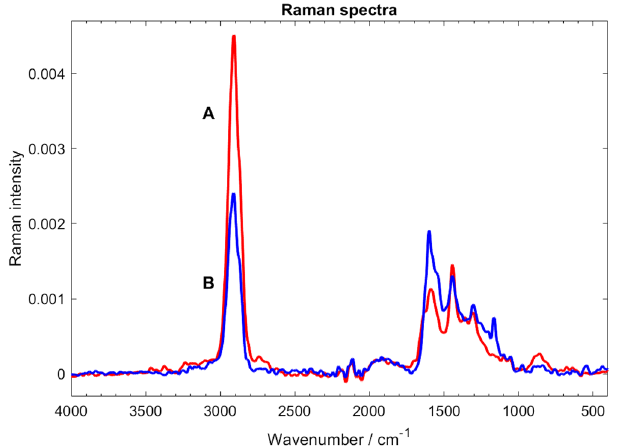
Figure 6. NIR FT-Raman spectra of sunflower (mark A, red curve) and rape (mark B, blue curve) sporopollenin P1-purified by Soxhlet extractions and P2-purified by TBPH. At 2910 cm −1 a strong aliphatic (mostly CH 2 stretching), while around 1600 cm −1 aromatic bands are located. Note the difference in aliphatic to aromatic ratios for the two